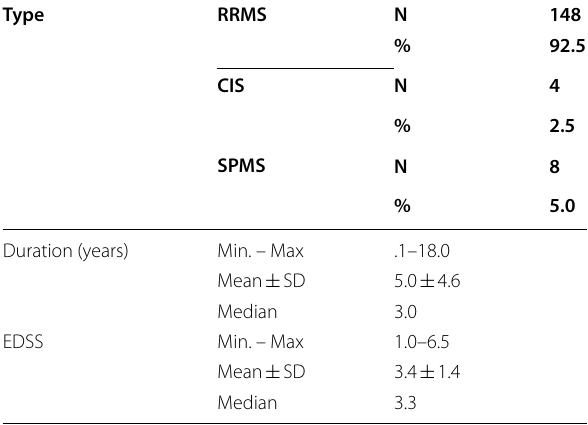
Table 3 Characters of the studied patients as regards the types of MS, duration, and EDSS